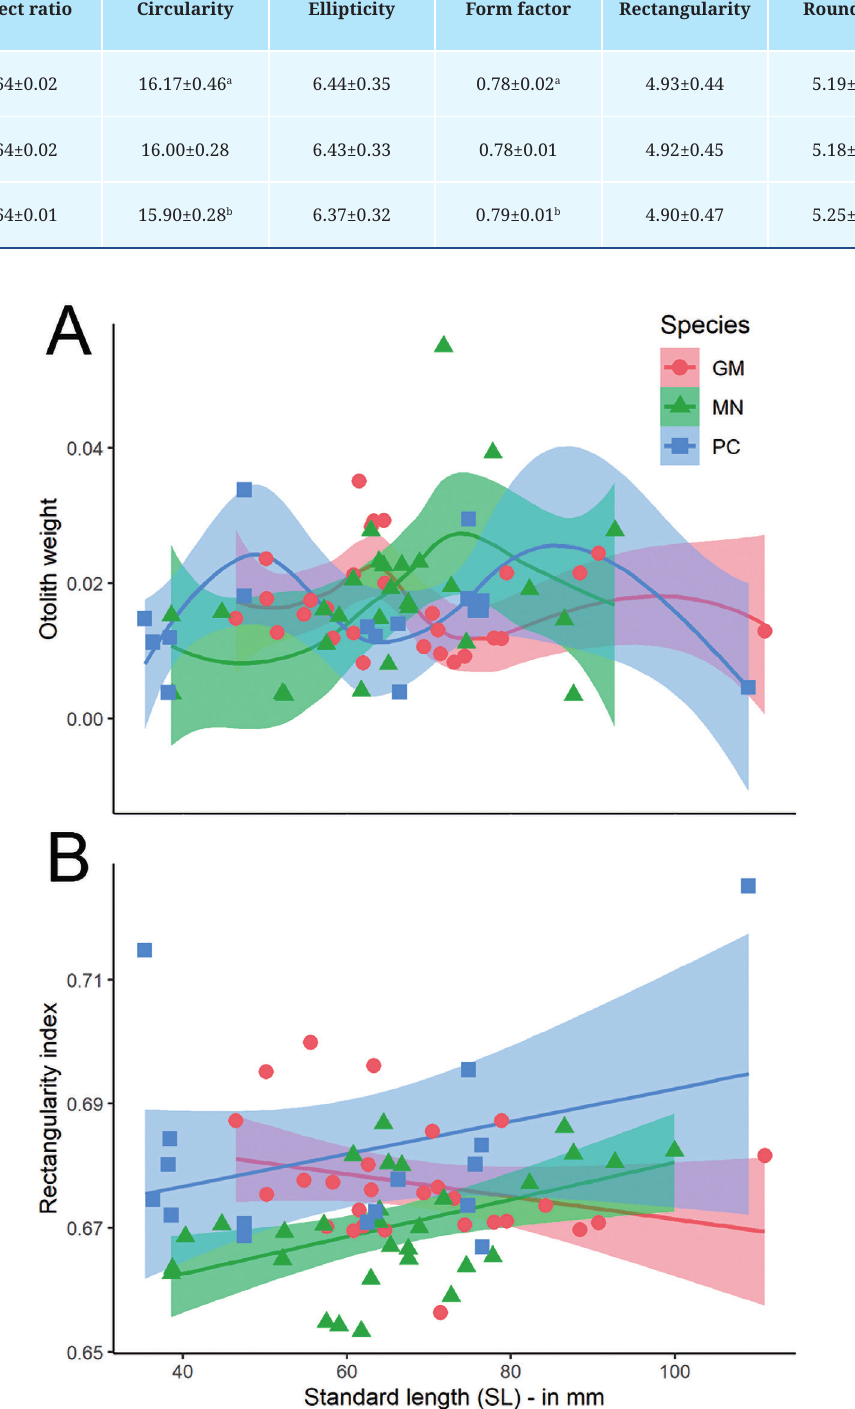
FIGURE 4 | A. Scatterplot of otolith weight using a LOESS curve fitting. B. Scatterplot of rectangularity index. GM = Stellifer gomezi , MN = S. menezesi , PC = S. punctatissimus .